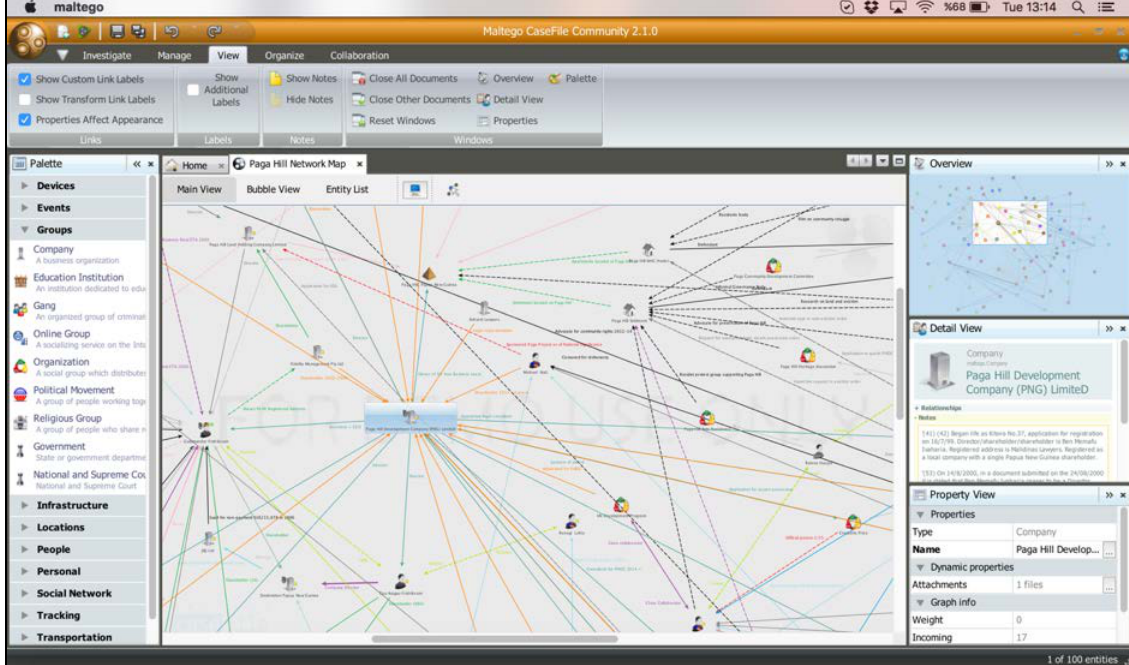
Figure 1: Modelling network data in Maltego Casefile